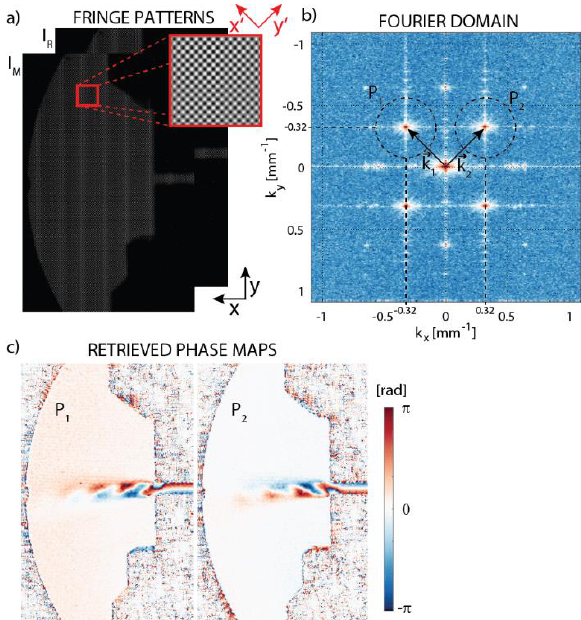
Fig. 5. Data processing: a) observed fringe pattern before IR and after IM the flow was presented; b) the amplitude Fourier spectrum with carrier frequencies; c) retrieved phase maps that proportional to fringe displacement in x’, y’ direction,